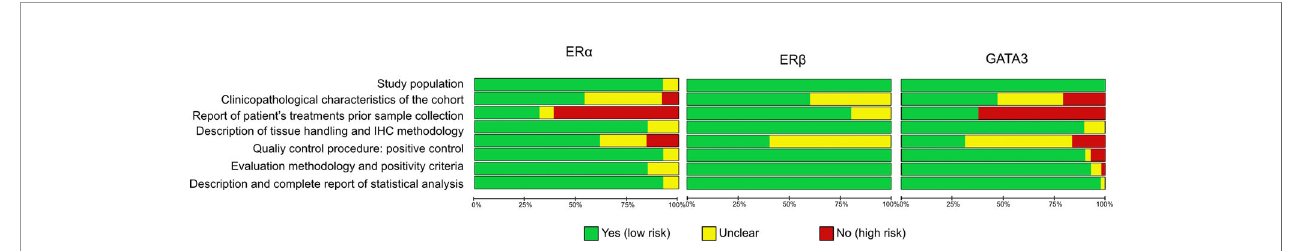
FIGURE 2 | Risk bias assessment per item presented as percentages across all included